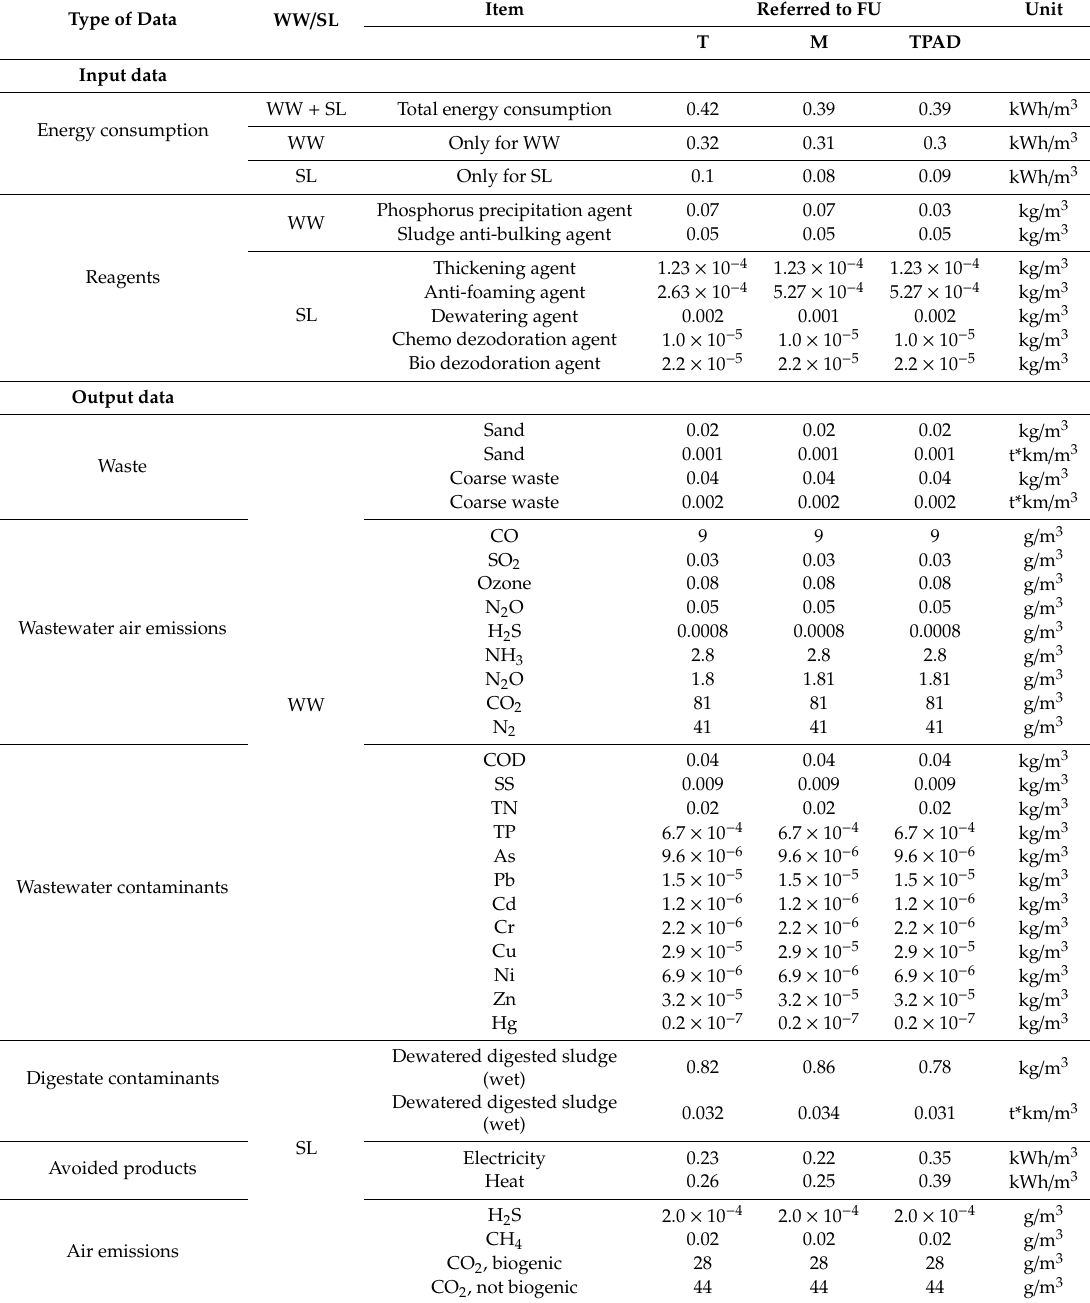
Table 2. Inventory data for the whole WWTP LCA (FU: 1 m 3 of treated wastewater). Type of